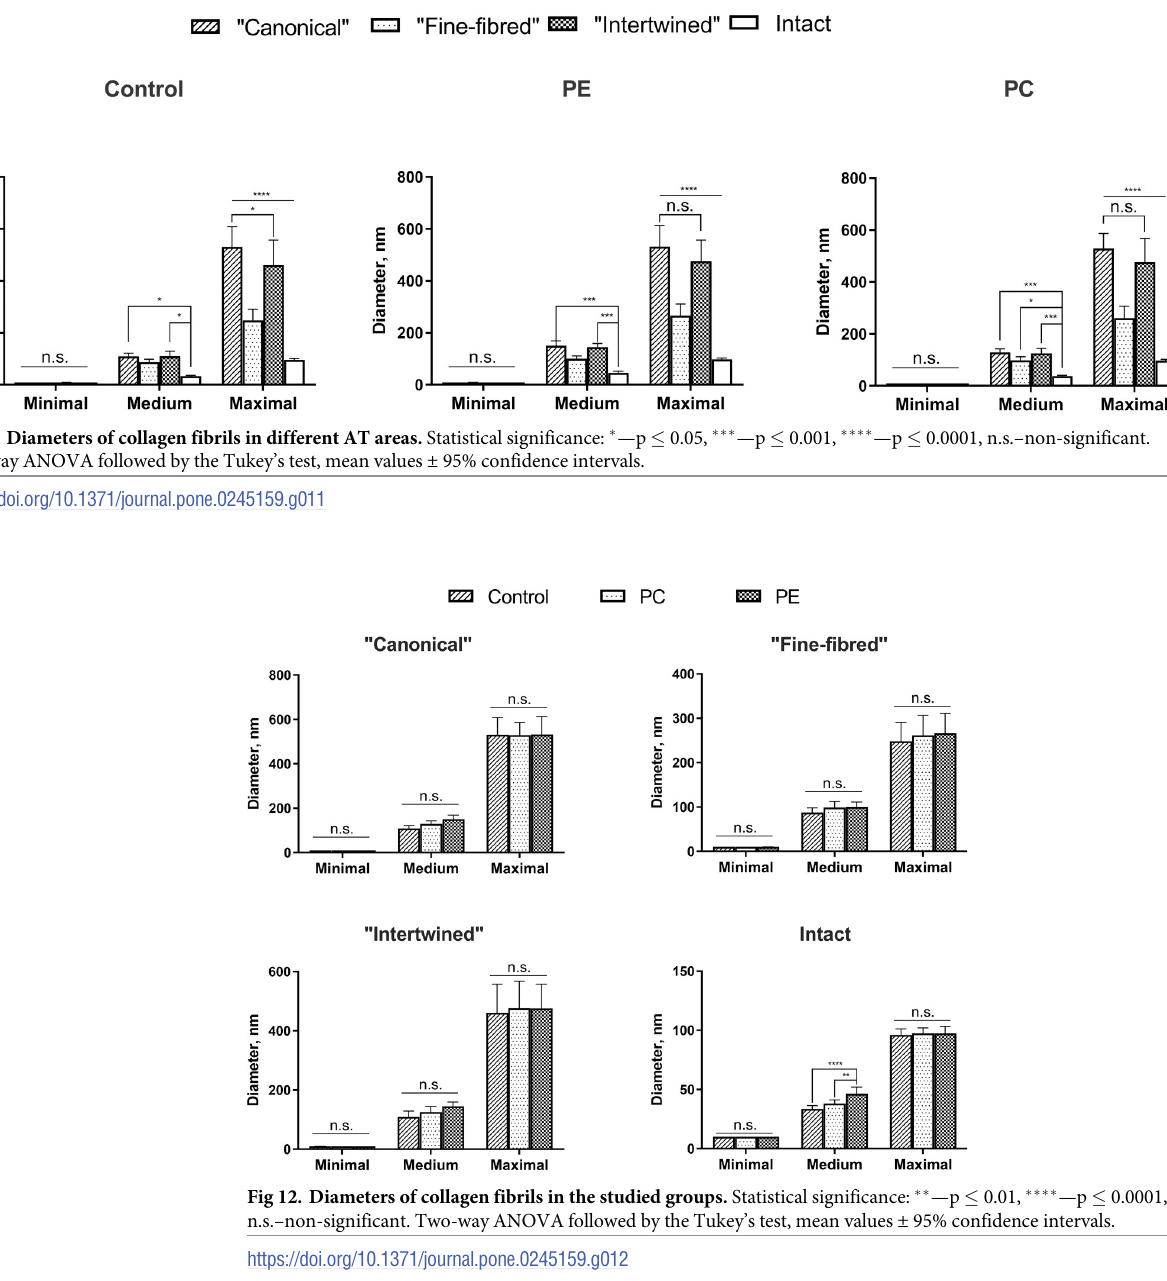
https://doi.org/10.1371/journal.pone.0245159.g010